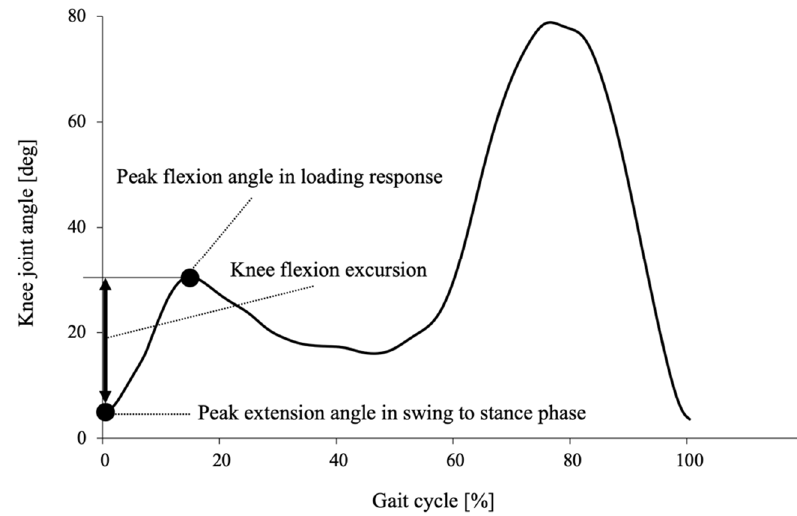
Figure 2. Example of time series data of the knee flexion angle in one gait cycle of a subject. Black dots indicate the values extracted for calculation of knee flexion excursion in loading response. Knee flexion excursion in the loading response was calculated from the amplitude of displacement between the peak extension angle at the initial contact and peak flexion angle in the loading response.